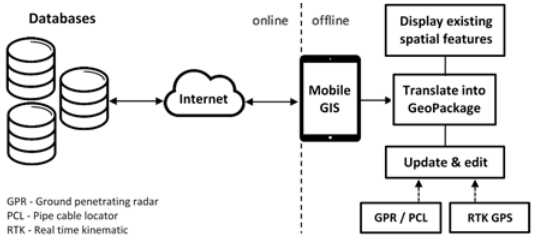
Figure 3. Utility mapping concept used in this study.